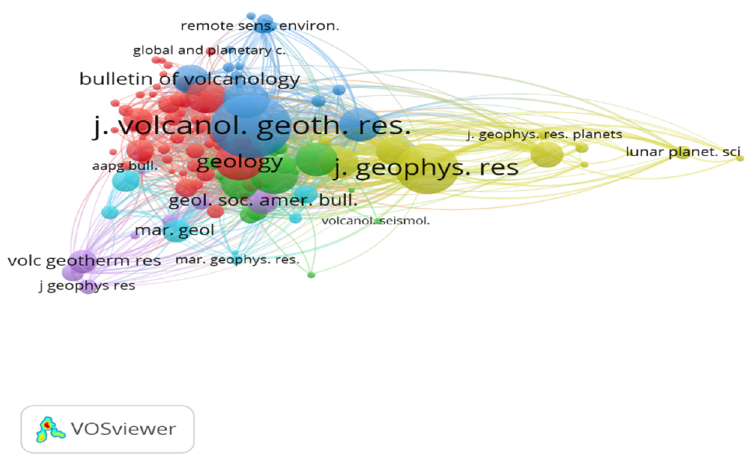
Figure 5. Bibliometric map of co-citation of journals.